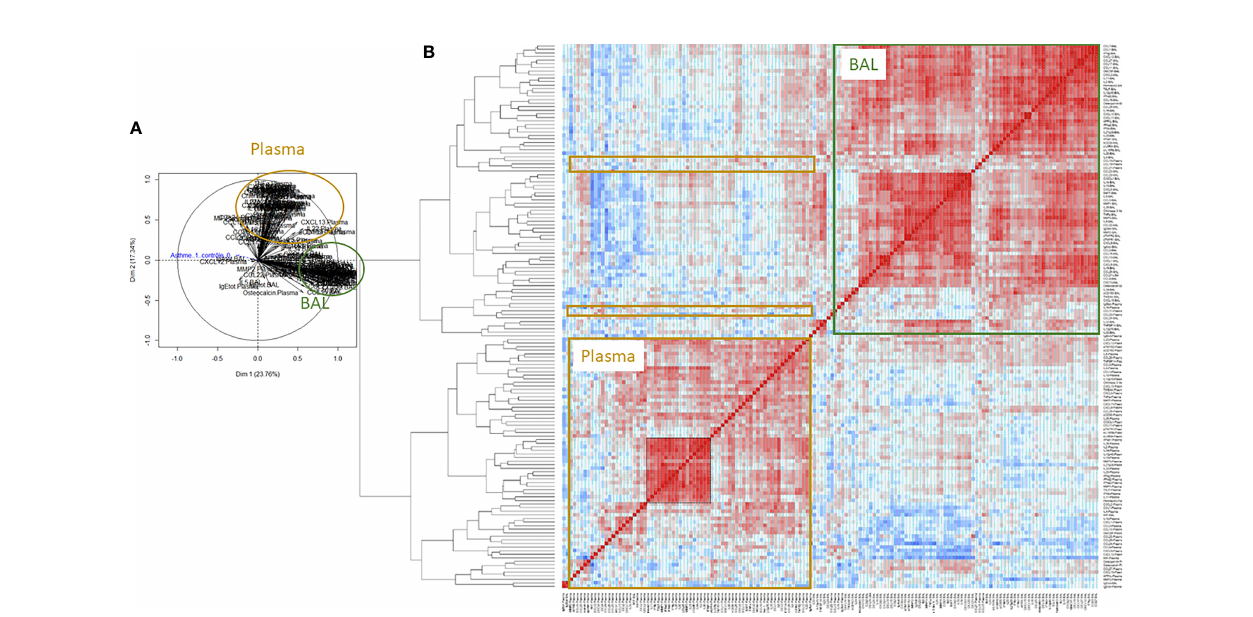
FIGURE 1 | Non-supervised Principal component analysis (PCA, (A) and heatmap of Spearman correlations (B) for all soluble components analyzed in BAL and plasma from SA and NA (n= 30). Positive correlations are shown in red, the absence of a correlation in white, and negative correlations in blue. The intensity of the color indicates the intensity of the correlation. The black square indicates a core of plasma cytokines that more highly correlated between themselves (comprising IFN a 2, IFN b , IFN g , IFN l 1, IFN l 2, IL-2, IL-11, IL-12p28, IL-12p40, IL-19, IL-20, IL-32, IL-34, IL-35, TSLP, MMP1, MMP3, and